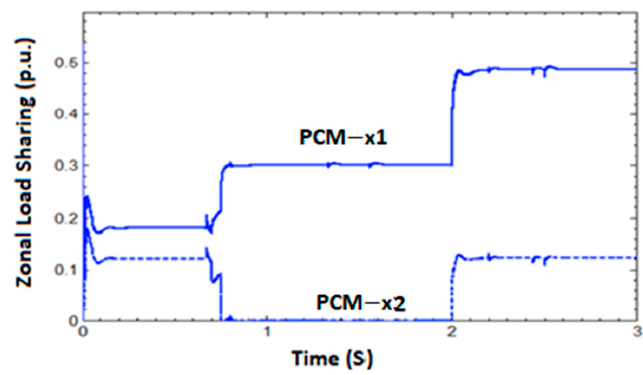
Figure 13. Load sharing in zone 1.